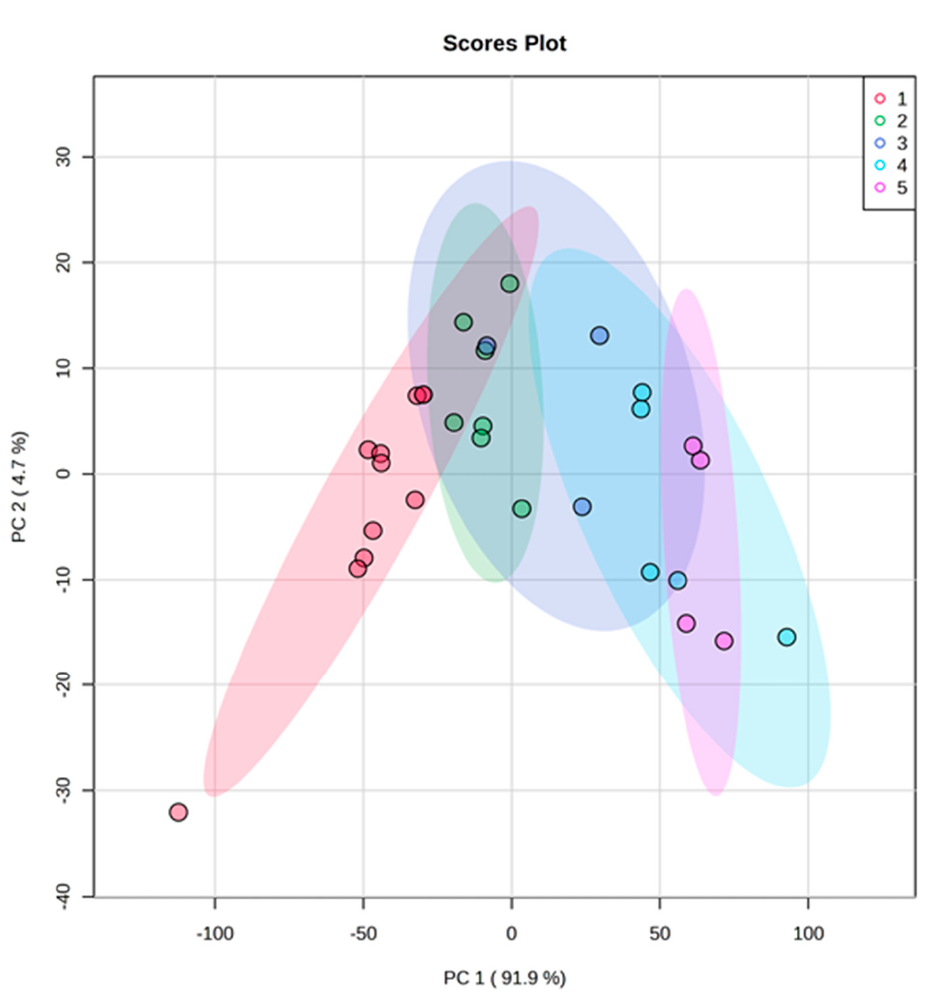
Figure 3. PCA scores plot of %ABV using FTIR data. Group 1—above 55%, Group 2—50–55%, Group 3—45–50%, Group 4—40–45%, Group 5—below 40%. Shaded areas are the 95% confidence regions.